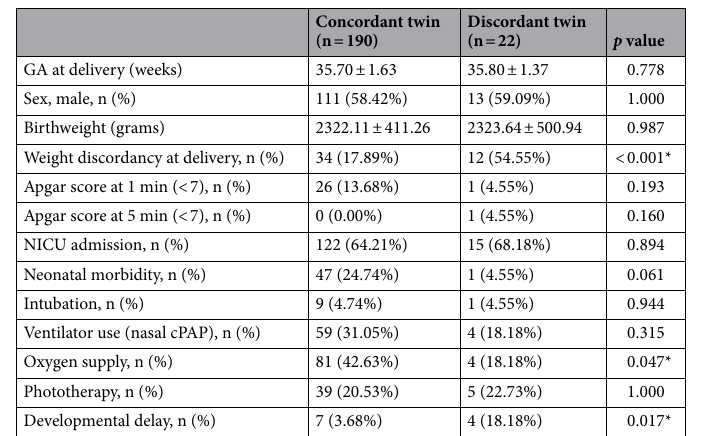
Table 2. Comparison of neonatal outcomes between concordant and discordant twins at 20–24 weeks of gestation in DCDA twins. DCDA, dichorionic diamniotic; GA, gestational age; NICU, neonatal intensive care unit; cPAP, continuous positive airway pressure. * p < 0.05, are shown in bold with an asterisk (*).